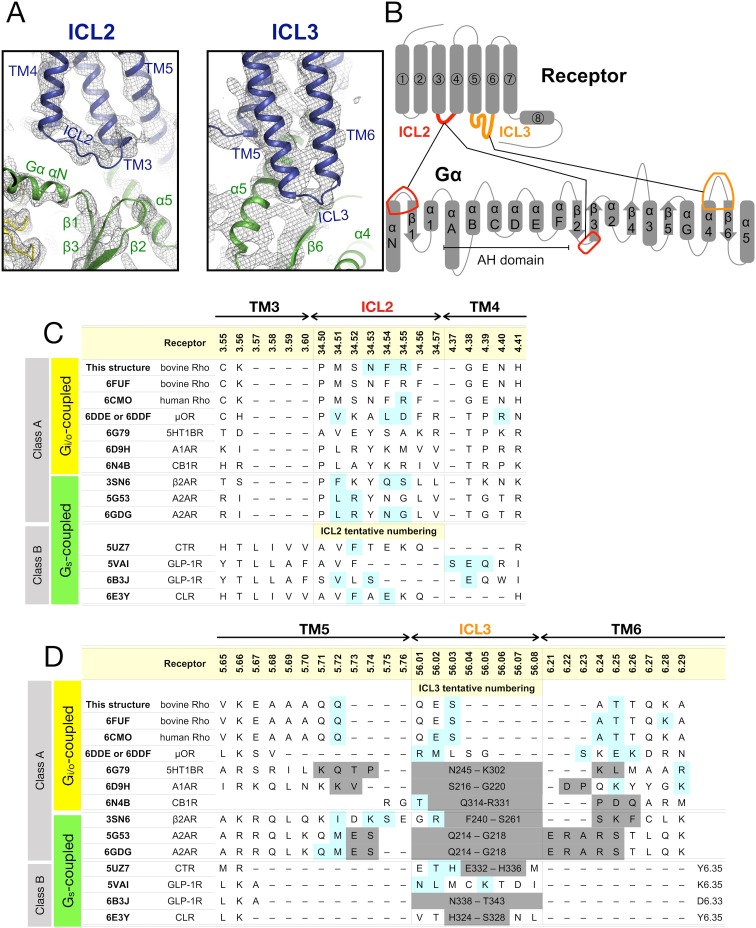
Contacts observed between ICL2/ICL3 and the Gα subunit.(A) Intracellular loop (ICL) 2 and 3 in the EM density map (B) Schematic overview of the contacts between the intracellular loops of the receptor and Gα. (C) Sequence of ICL2 in the available structures of the GPCR-G protein complexes. Residues that contact to regions of the G protein other than the α5 helix are highlighted in cyan. (D) Same as panel B, but for ICL3. Residues missing from the structure are marked in gray. The residues are numbered using the Ballesteros-Weinstein scheme.